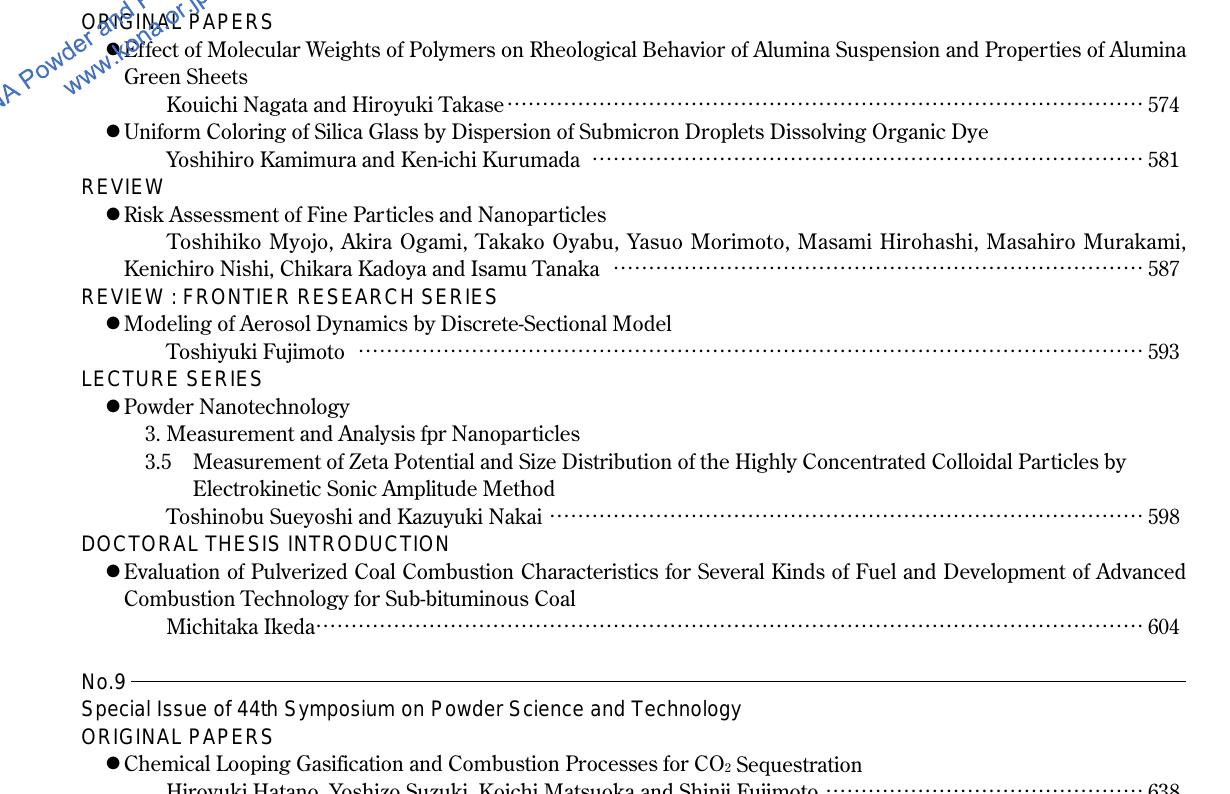
・ Effect of Molecular Weights of Polymers on Rheological Behavior of Alumina Suspension and Properties of Alumina Green